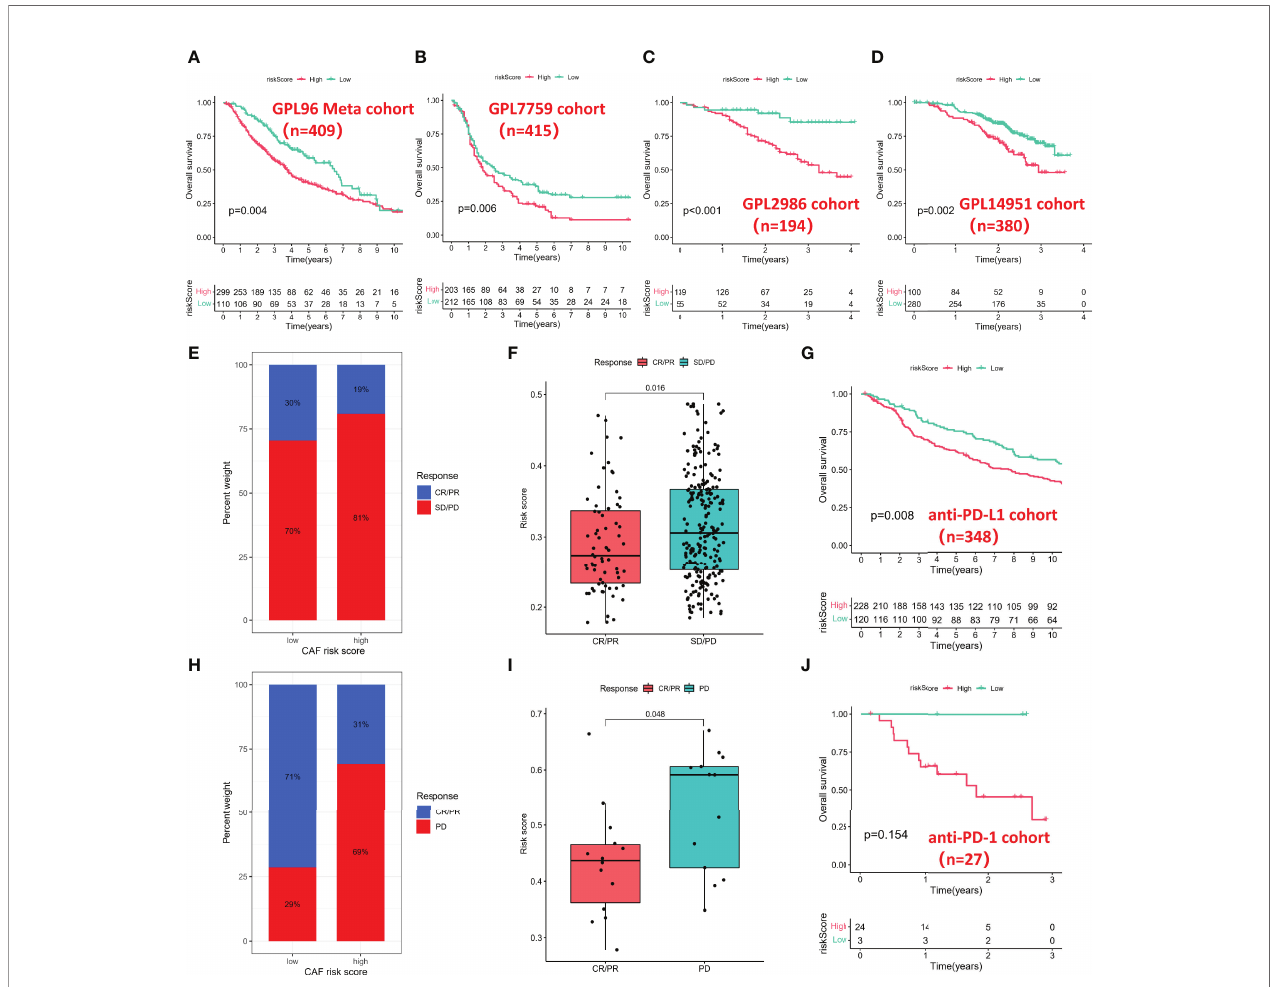
FIGURE 6 | Multidimensional validation for risk score. (A) Kaplan – Meier analysis in the GPL96 meta-cohort. (B) Kaplan – Meier analysis in the GPL7759 cohort. (C) Kaplan – Meier analysis in the GPL2986 cohort. (D) Kaplan – Meier analysis in the GPL14951 cohort. (E) Histogram of anti-PD-L1 response distribution in different risk groups. (F) Box plot of risk score in different anti-PD-L1 response groups. (G) Kaplan – Meier analysis in the anti-PD-L1 cohort. (H) Histogram of anti-PD-1 response distribution in different risk groups. (I) Box plot of risk score in different anti-PD-1 response groups. (J) Kaplan – Meier analysis in the anti-PD-1 cohort. PD-1, Programmed Death-1; PD-L1, Programmed Cell Death 1